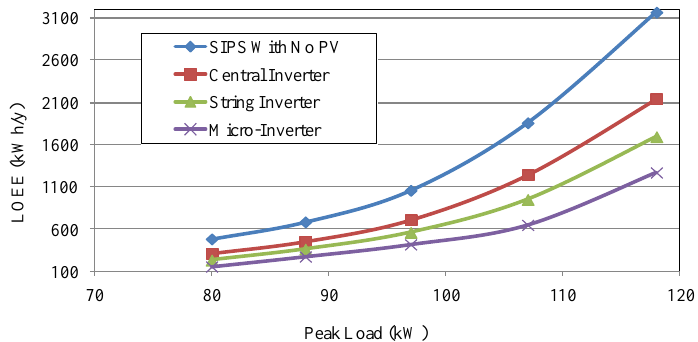
Figure 13. Variation in risk level (LOEE) with system demand load for different PV topologies.